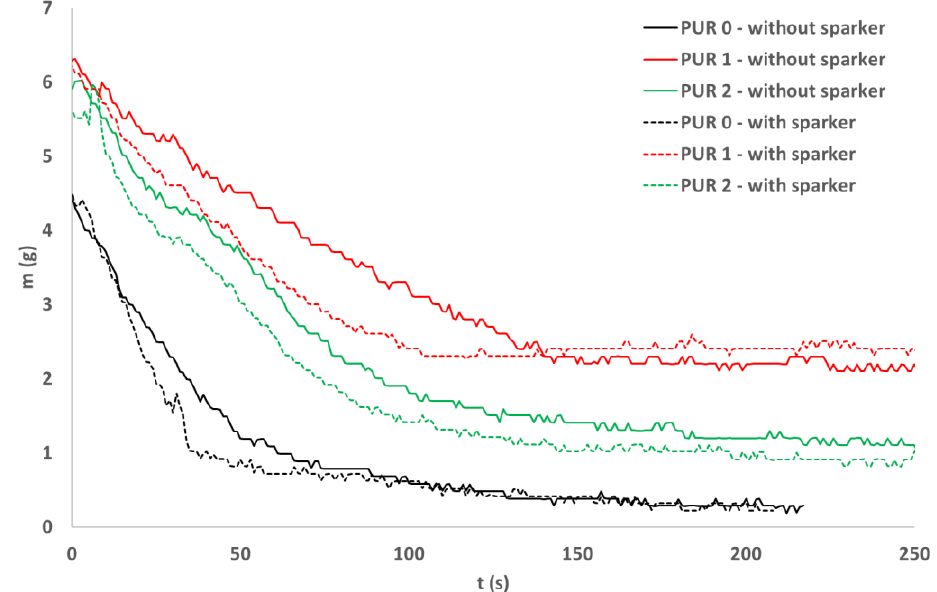
Figure 9. Mass loss of PUR samples exposed to the 40 kW/m 2 heat flow; self-ignition and spark ig- nition.